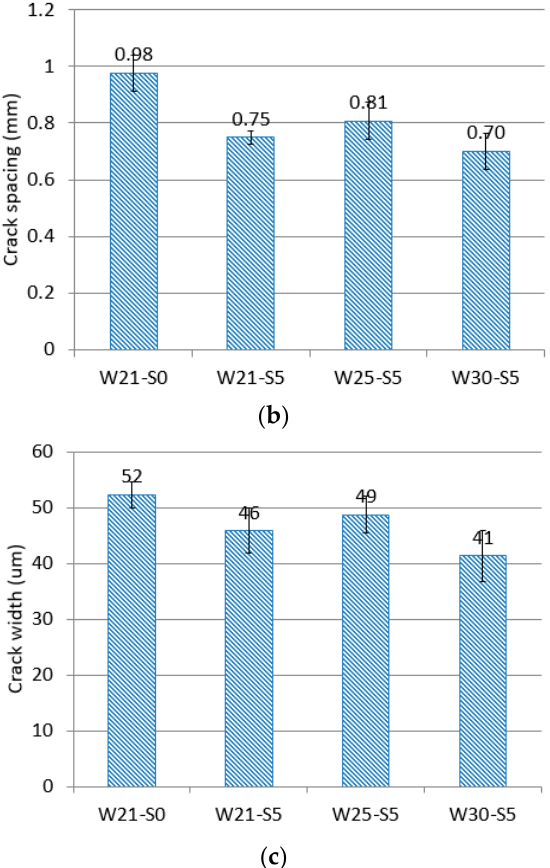
Figure 10. Average cracking patterns: ( a ) number of cracks within gauge length (80 mm), ( b ) crack spacing, and ( c ) crack width.